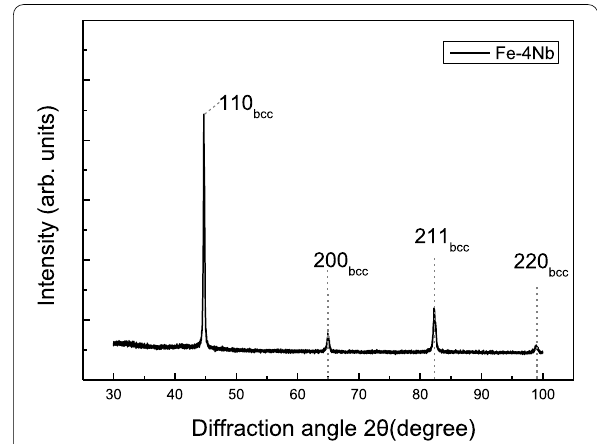
Fig. 1 XRD analysis to determine the existing phase of 4Nb(wt.%) added Fe-based